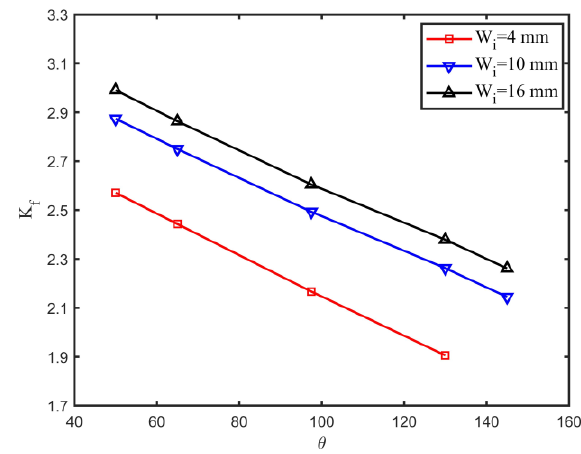
Figure 9. The effect of weld root angle (δ = 0, h = 2 mm).